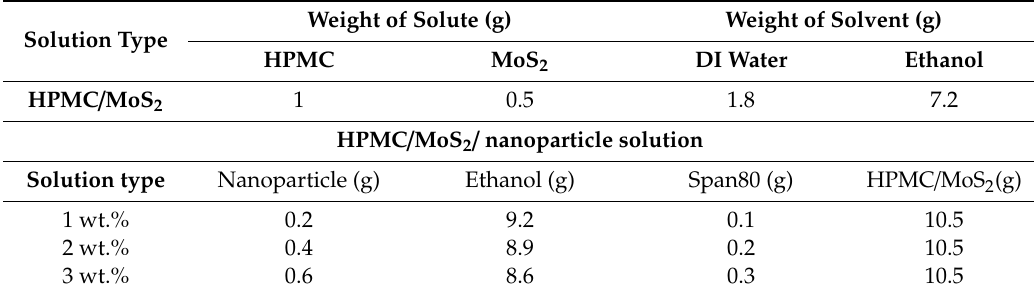
Table 1. Preparation parameters of hydroxypropyl methylcellulose (HPMC)-based composite solution.